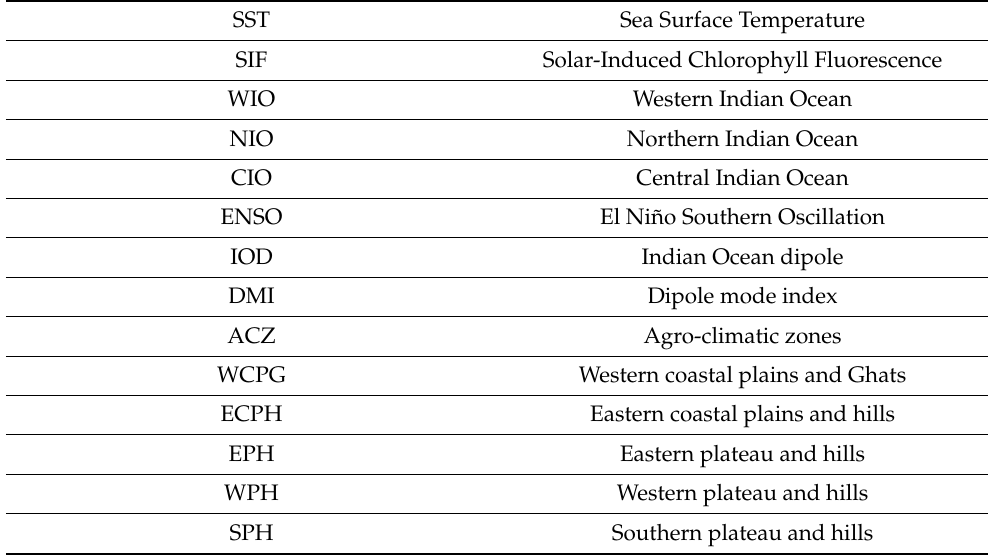
Table 2. List of